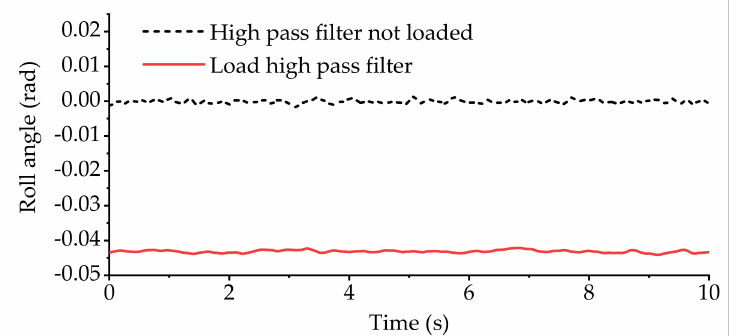
Figure 20. Roll angle of vehicle body in longitudinal slope experiment.